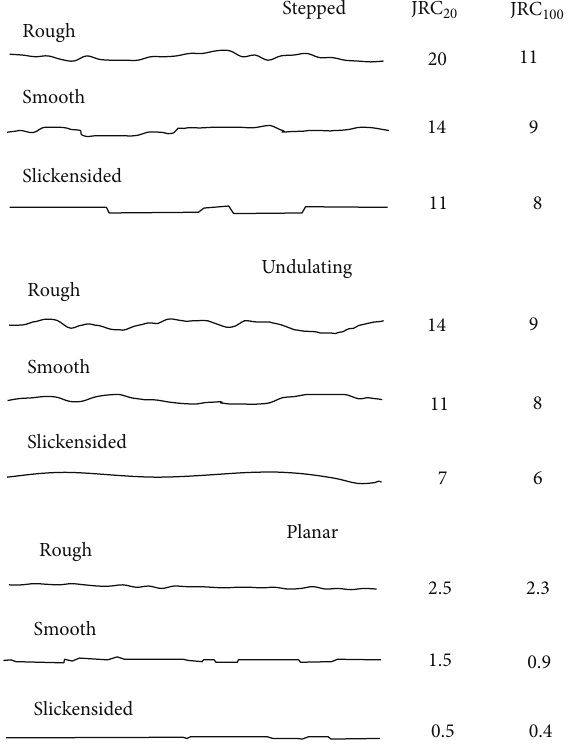
of extensive field investigations of rock joint surface shapes, generalized models for three level shapes such as macroscopic outline, surface undulating shape, and microcosmic rough- ness were established through statistical analyses of 20,078 rock joint surface profiles. The relative amplitude of profile curves was used as a borderline for the division of different level shapes.